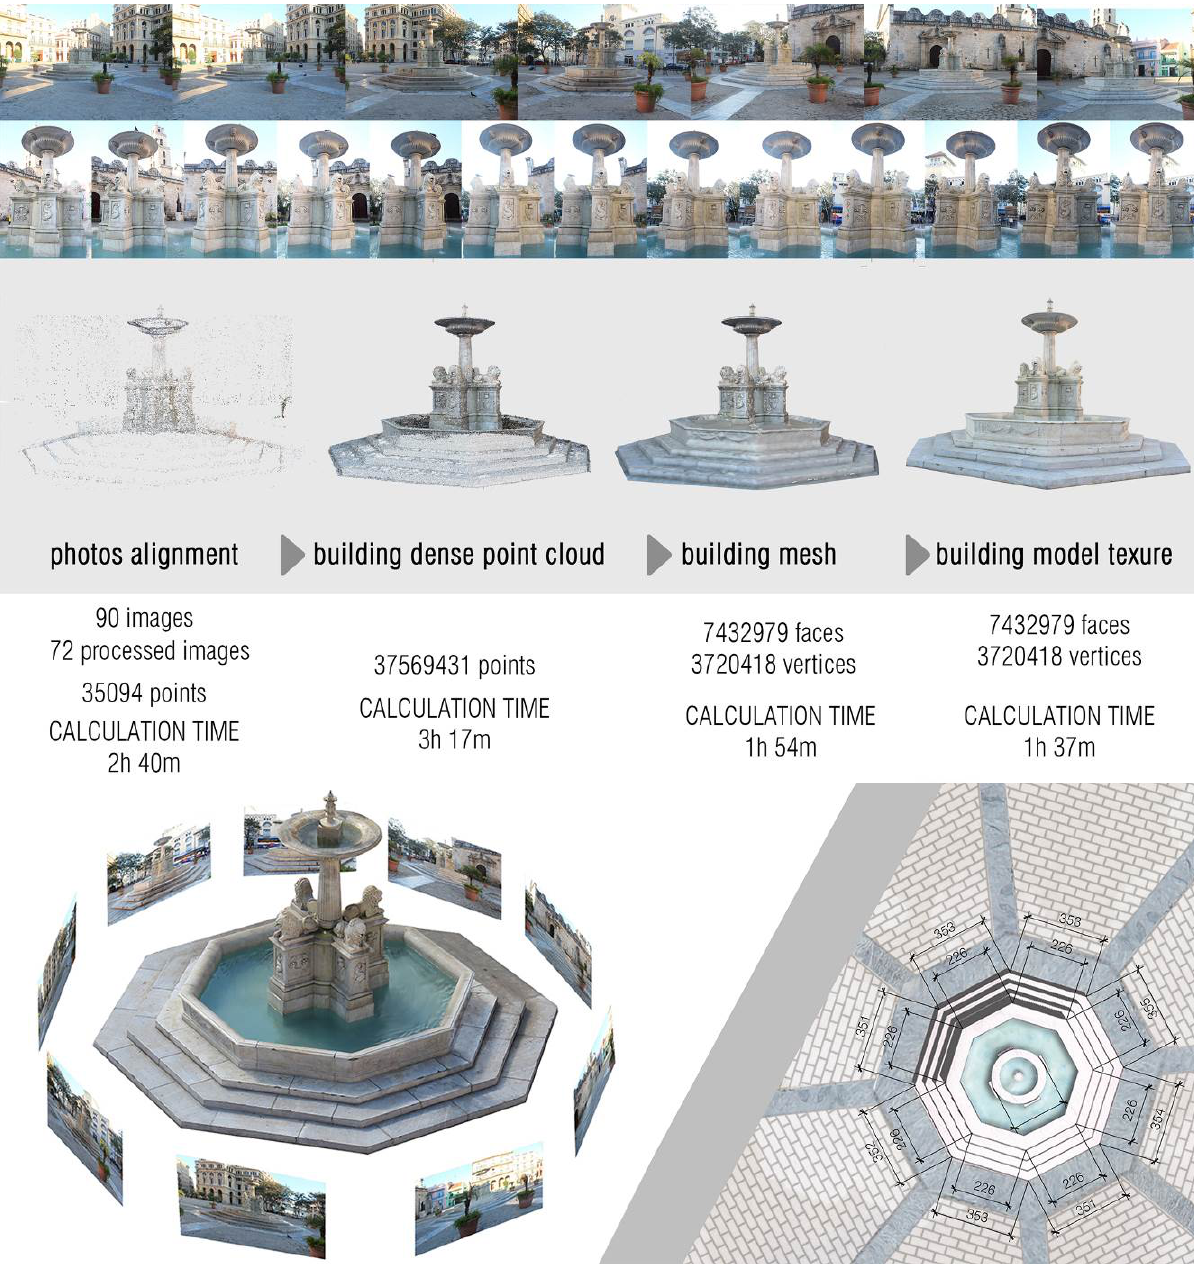
Figure 10. Application of photo-modelling (fountain in Plaza de San